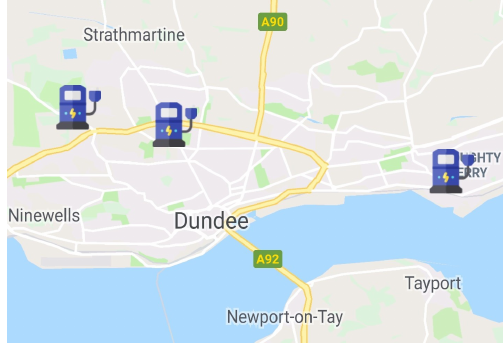
Figure 3. Location of CS on the